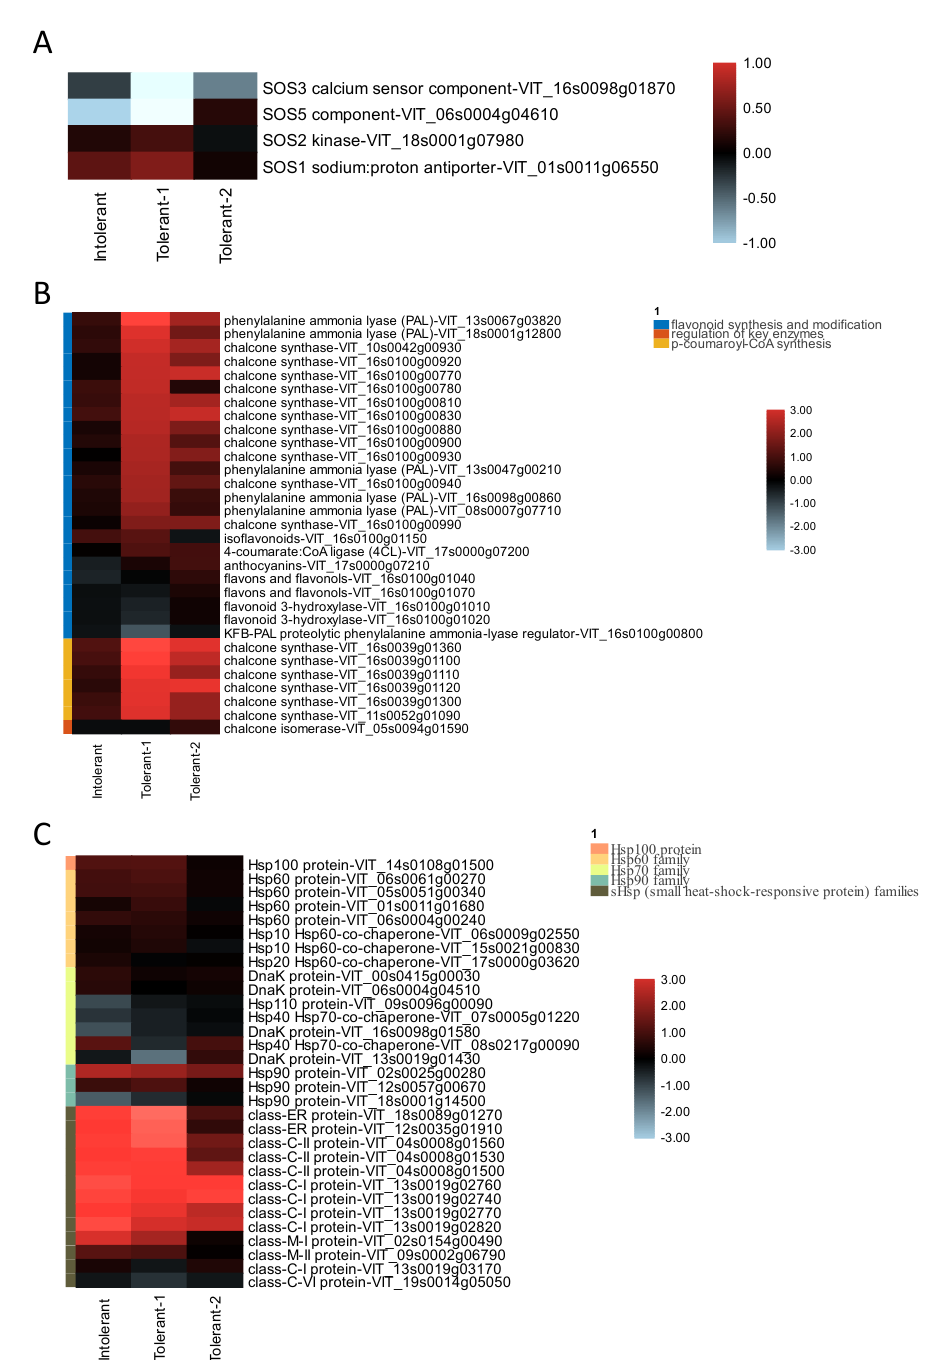
Figure 6. Expression analysis of DEGs related to the defense system under salt stress. Expression analysis of the DEGs involved in ( A ) the SOS gene family, ( B ) phenylpropane metabolism, and ( C ) the HSP gene family under the salt treatment. Each column represents a different tolerance level and each row represents a gene. Red indicates upregulated expression of a DEG and blue indicates downregulated expression. The colors on the left side of the gene are clustered by gene